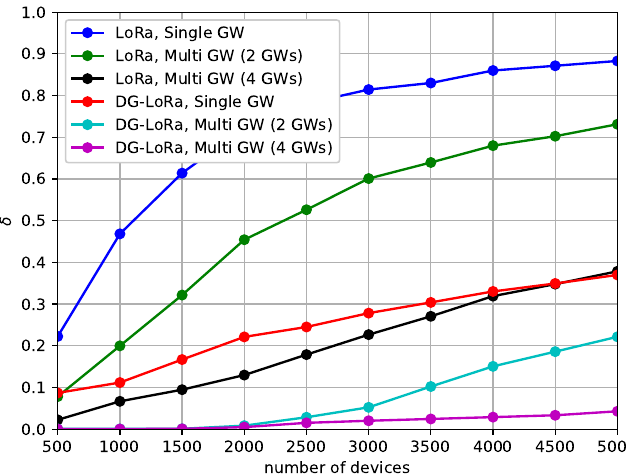
Figure 11. The number of retransmissions according to the number of gateways.